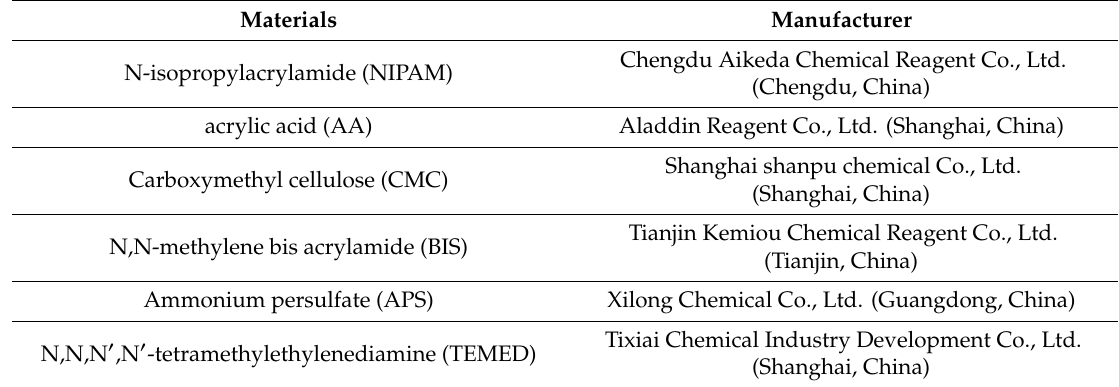
Table 1. List of the main materials for the preparation of the temperature sensitive hydrogel.